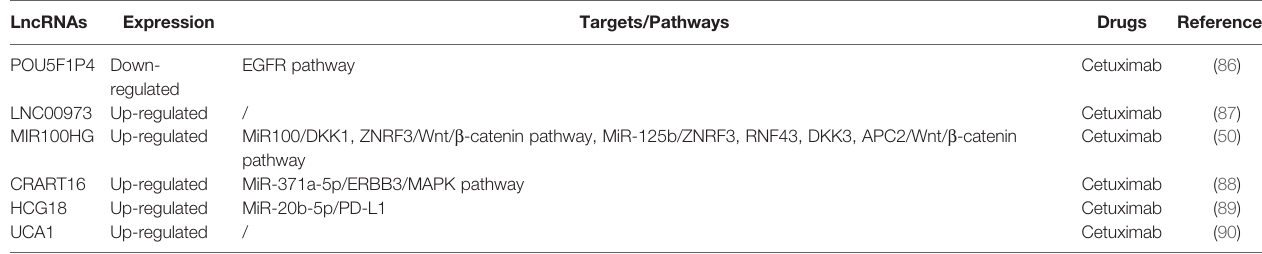
TABLE 2 | LncRNAs involved in anti-EGFR drugs resistance in CRC.